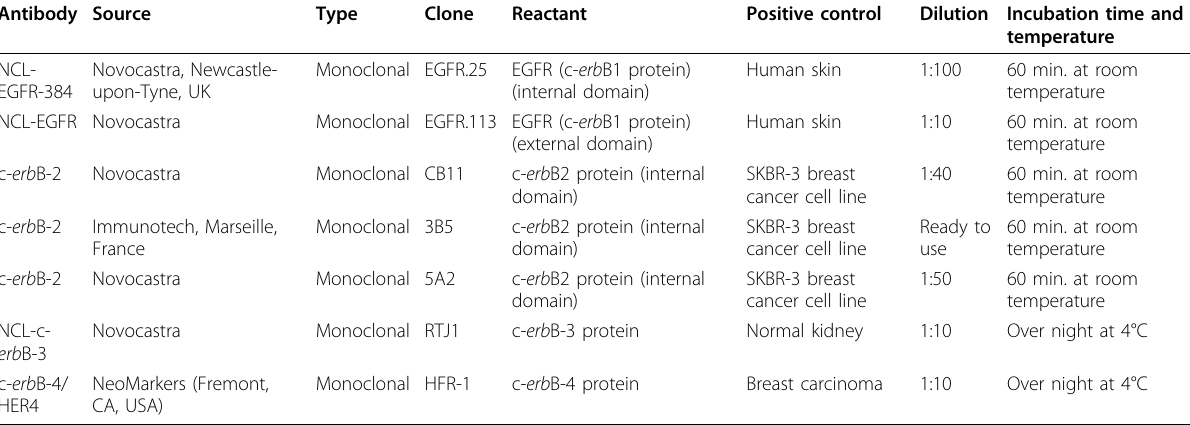
Table 1 erb B antibodies used Antibody Source